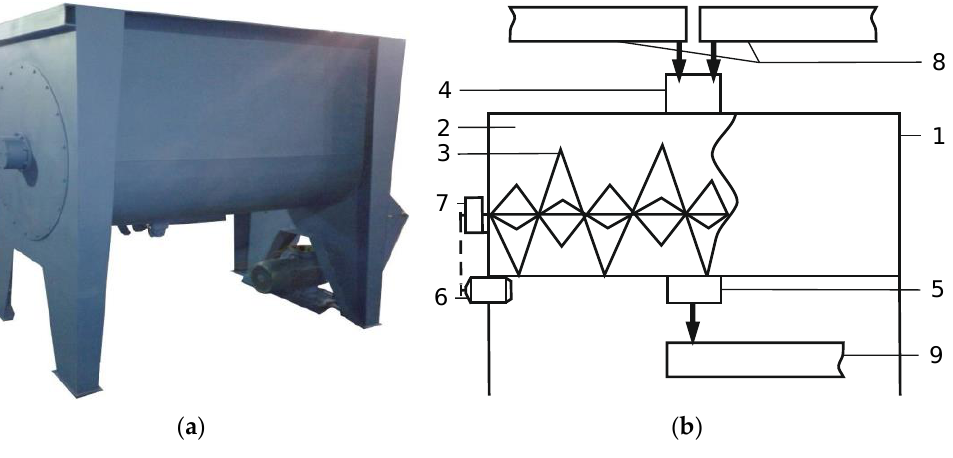
Figure 2 . Mixer: ( a ) general view; ( b ) structural-technological scheme: 1—body; 2—mixing chamber, 3—mixer; 4—filling chamber; 5—discharge chamber ; 6-engine; 7—reductor; 8—supply screw feeder; 9—discharge screw feeder.